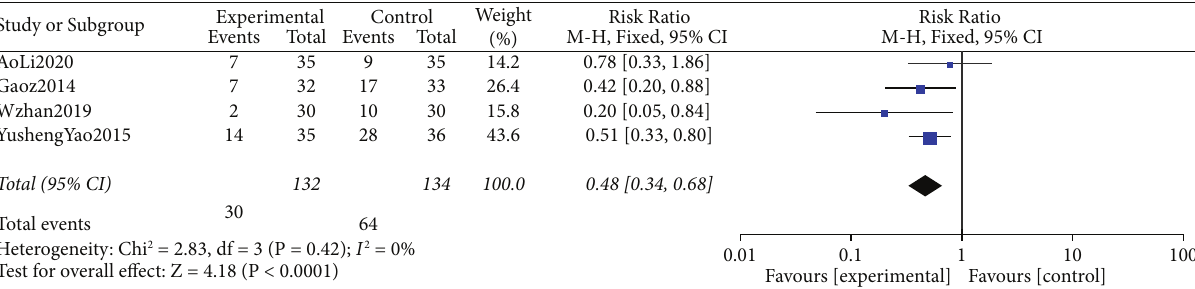
Figure 4: Forest plots comparing the incidence of postoperative dizziness between the TEAS and control